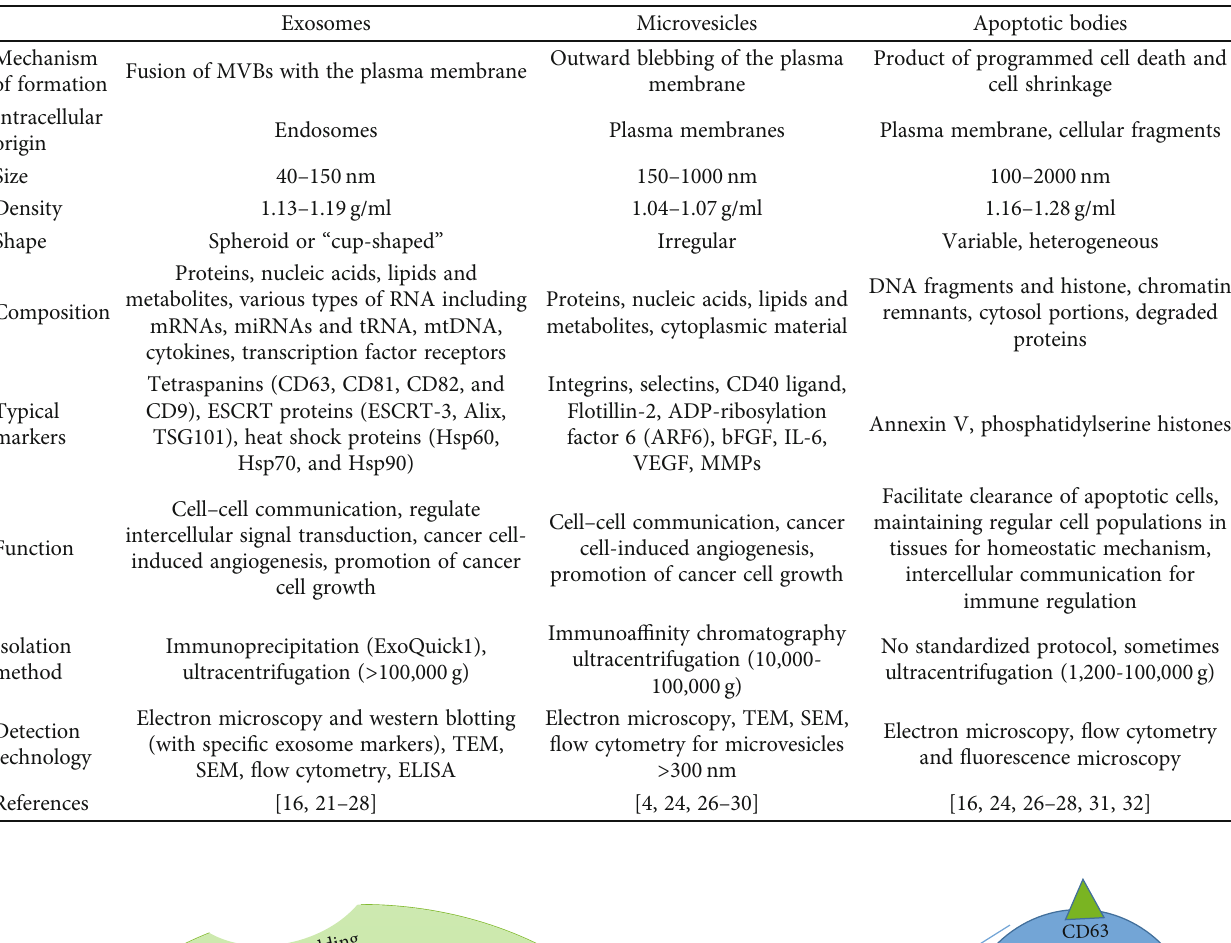
Table 1: Features of extracellular vesicle subtypes.